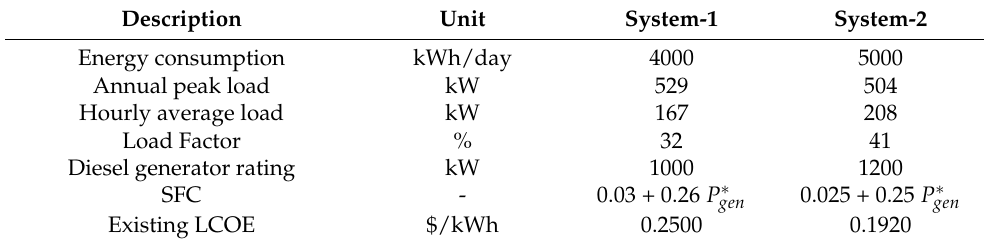
Table 1. Data summary of System-1 and System-2. System-1 had lower energy consumption and hourly average load but higher peak load compared to System-2. System-1 had a lower load factor than